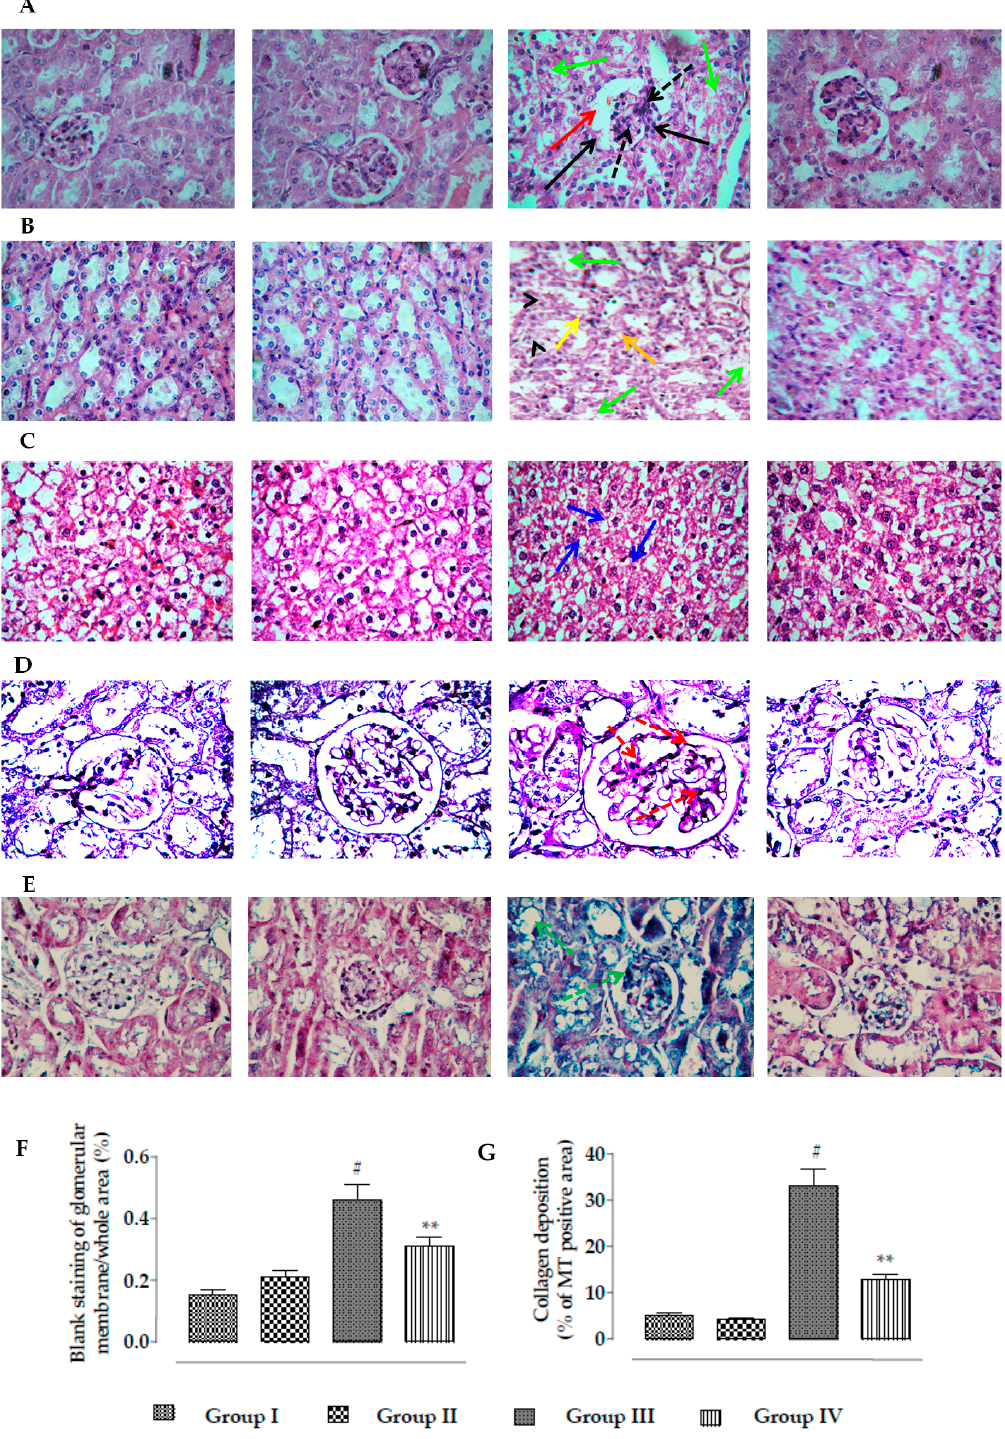
Figure 12. Histological assessments of kidneys of experimental mice in the absence (CdCl 2 ) and presence of RA (CdCl 2 + RA). ( A ) The H&E-stained sections of mice kidneys ( × 100), ( B )